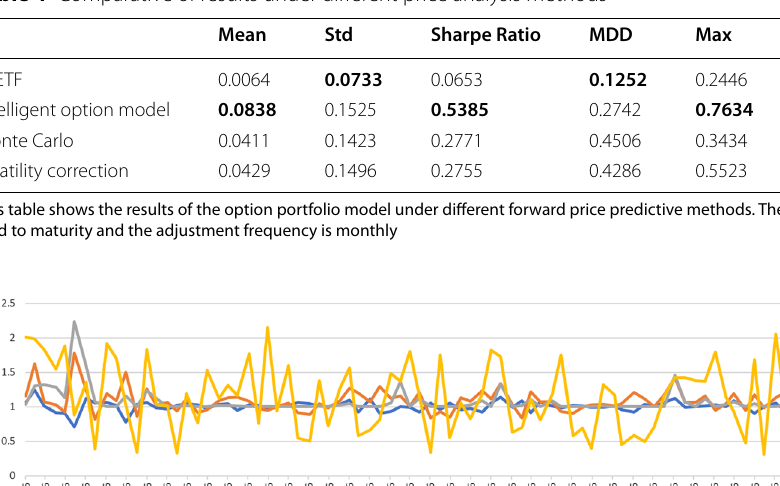
Table 4 Comparative of results under different price analysis methods Mean